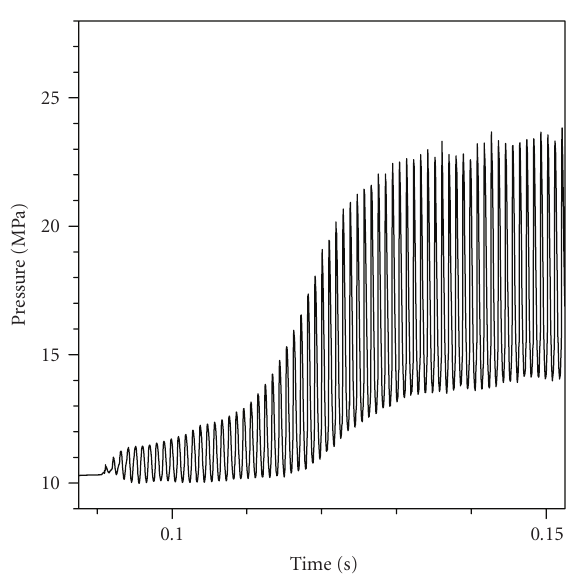
Figure 2: Predicted unsteady head-end pressure-time profile, for SRM undergoing axial combustion instability symptoms ( K b = 20000 s − 1 , Δ H s = 150 000J/kg, Δ p d =